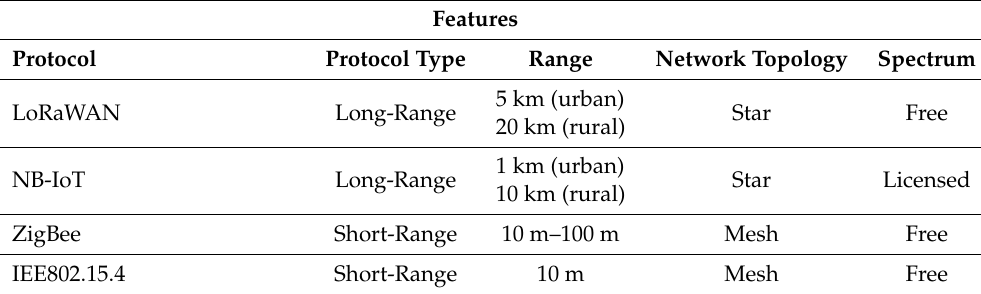
Table 7. Sensor networking